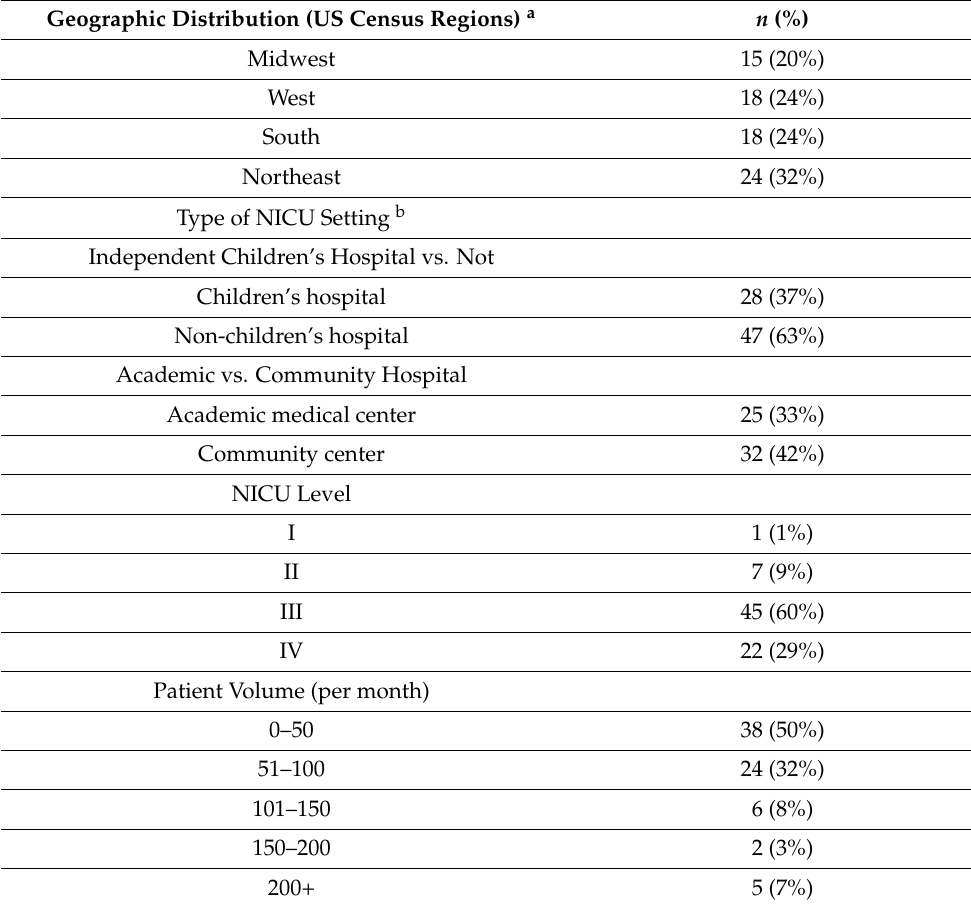
Table 1. Characteristics of participating NICU programs ( n =